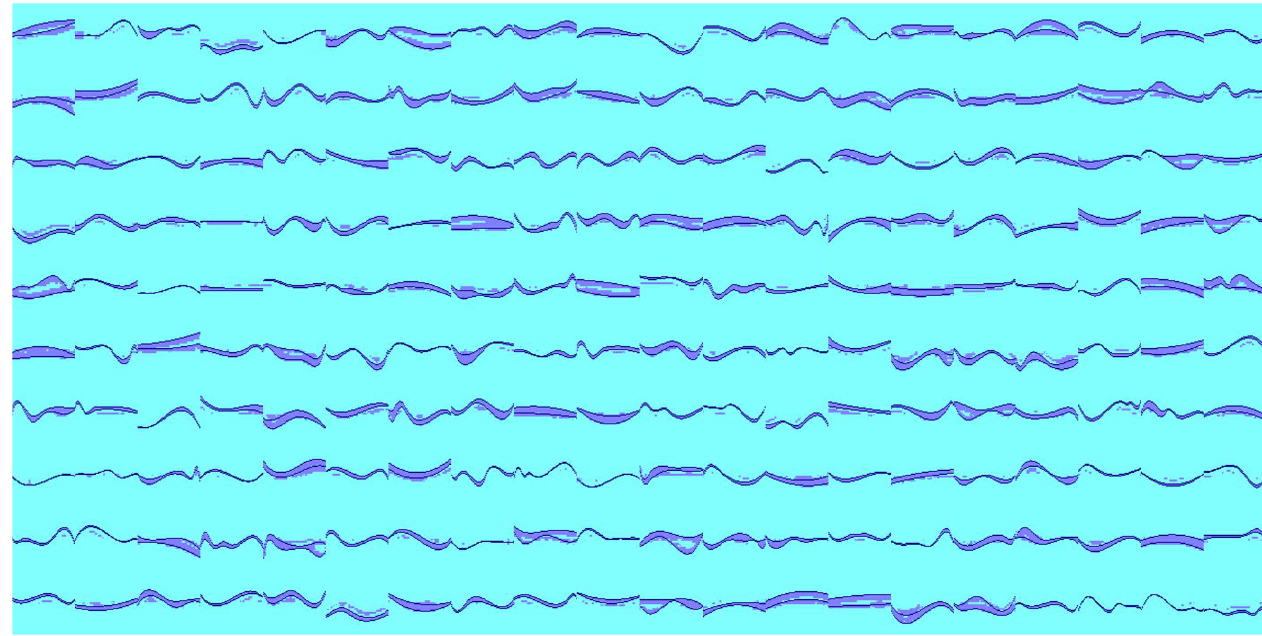
Fig. 7. The segmentation result after turning the DropOut layer on (following the single DeConvL) by Fig. 4. The SSN trained for 36 epochs starts segmenting the empty image and thus the training process is stopped. The global and mean accuracies here are a bit greater than those for the SSN without DropOut. Contrariwise, the mean IoU and mean BF score are significantly improved (Table II). The weighted IoU is improved as well. However, the mean BF score is still unsatisfactory. Although the SSN “sees” thicker regions better than the SSN without DropOut, the gaps inside their interiors did not disappear. The erroneously segmented pixels on outside of the regions are still clearly seen. Therefore, SIS by the shallow SSN architecture (Fig. 4) is still “dirty” and cannot be accepted.